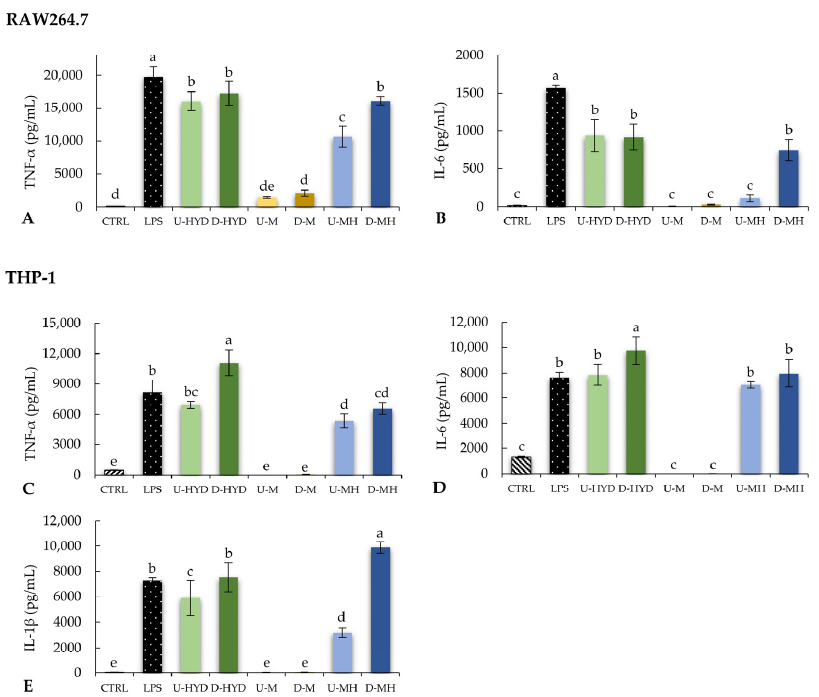
Figure 2. Evaluation of cytokine production by RAW264.7 and THP-1 cells treated with LPS (1 µg/mL) or undigested (U) and digested (D) HYD, M, and MH at 0.5 mg/mL for 24 h. Levels of ( A ) murine tumour necrosis factor (TNF)- α , ( B ) murine interleukin (IL)-6, ( C ) human TNF- α , ( D ) human IL-6, and ( E ) human IL-1 β . Bars represent means, and error bars represent standard deviations (n = 8). Different lowercase letters show significant differences from each other (one-way ANOVA, post hoc Duncan’s test, p ≤ 0.05). Abbreviations: untreated cells (CTRL); lipopolysaccharide from E. coli O55:B5 (LPS); undigested WB hydrolysate (U-HYD); digested WB hydrolysate (D-HYD); undigested control mousse (U-M); digested control mousse (D-M); undigested mousse with WB hydrolysate (U-MH); and undigested mousse with WB hydrolysate